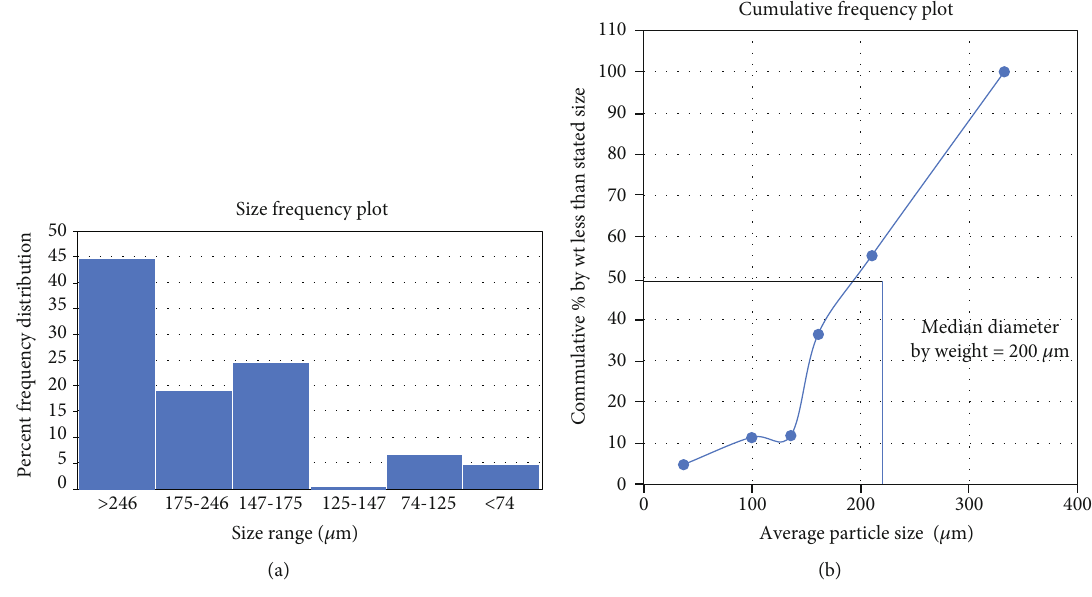
Figure 2: (a) Size frequency distribution of granules and (b) cumulative frequency plot. Table 4: EC50 values (mg/ml) of granules, mixture, and metformin. Sample